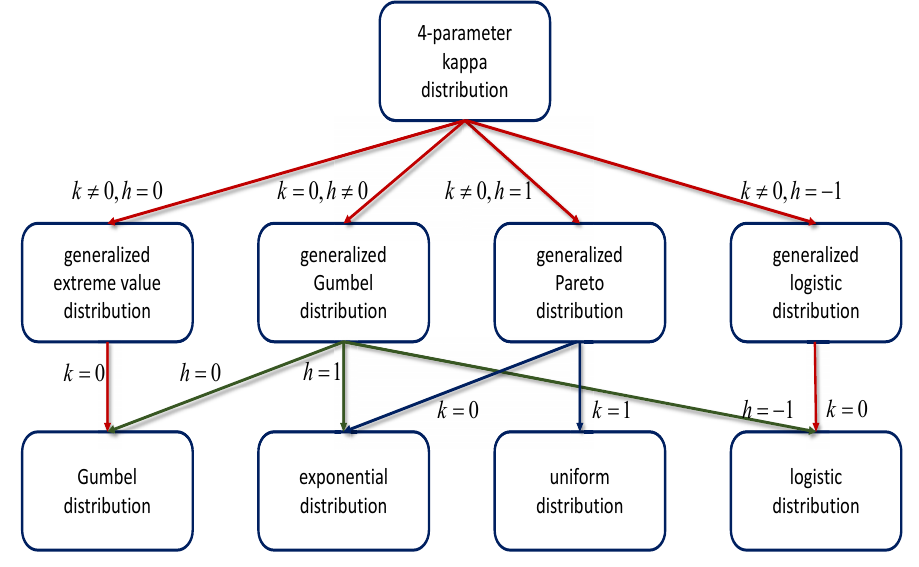
Figure 1. Relationship of the four-parameter kappa distribution to other three-parameter and two-parameter distributions with varying shape parameters k and h